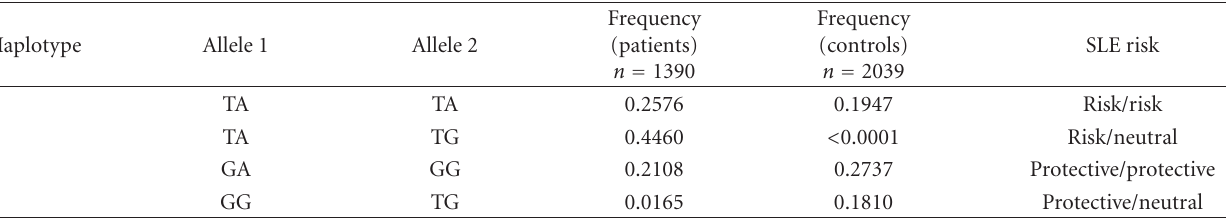
Table 1: Frequency of IRF5 haplotypes in lupus patients and healthy controls. Haplotype frequencies observed in controls and systemic lupus erythematosus (SLE) patient cohort at single-nucleotide polymorphisms rs2004640 ( T : risk, G: protective) and rs10954213 ( A: risk, G: protective).